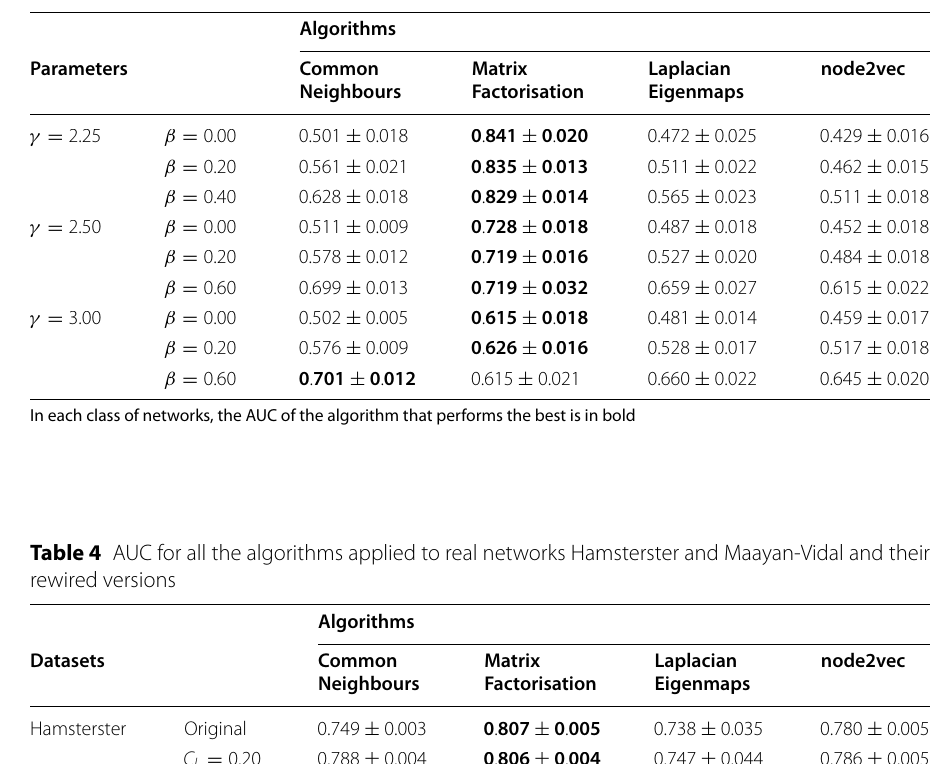
Table 3 AUC for all the algorithms applied to the networks generated by the Polynomial model